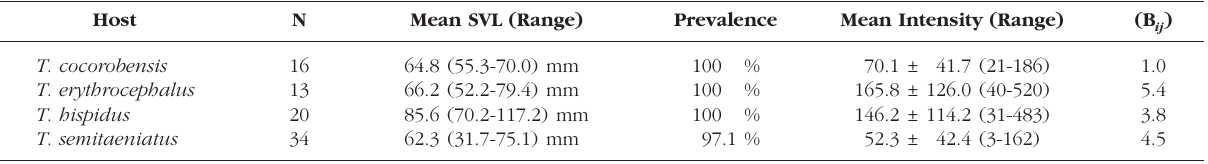
) of the ectoparasitic mite Eutrom- ij